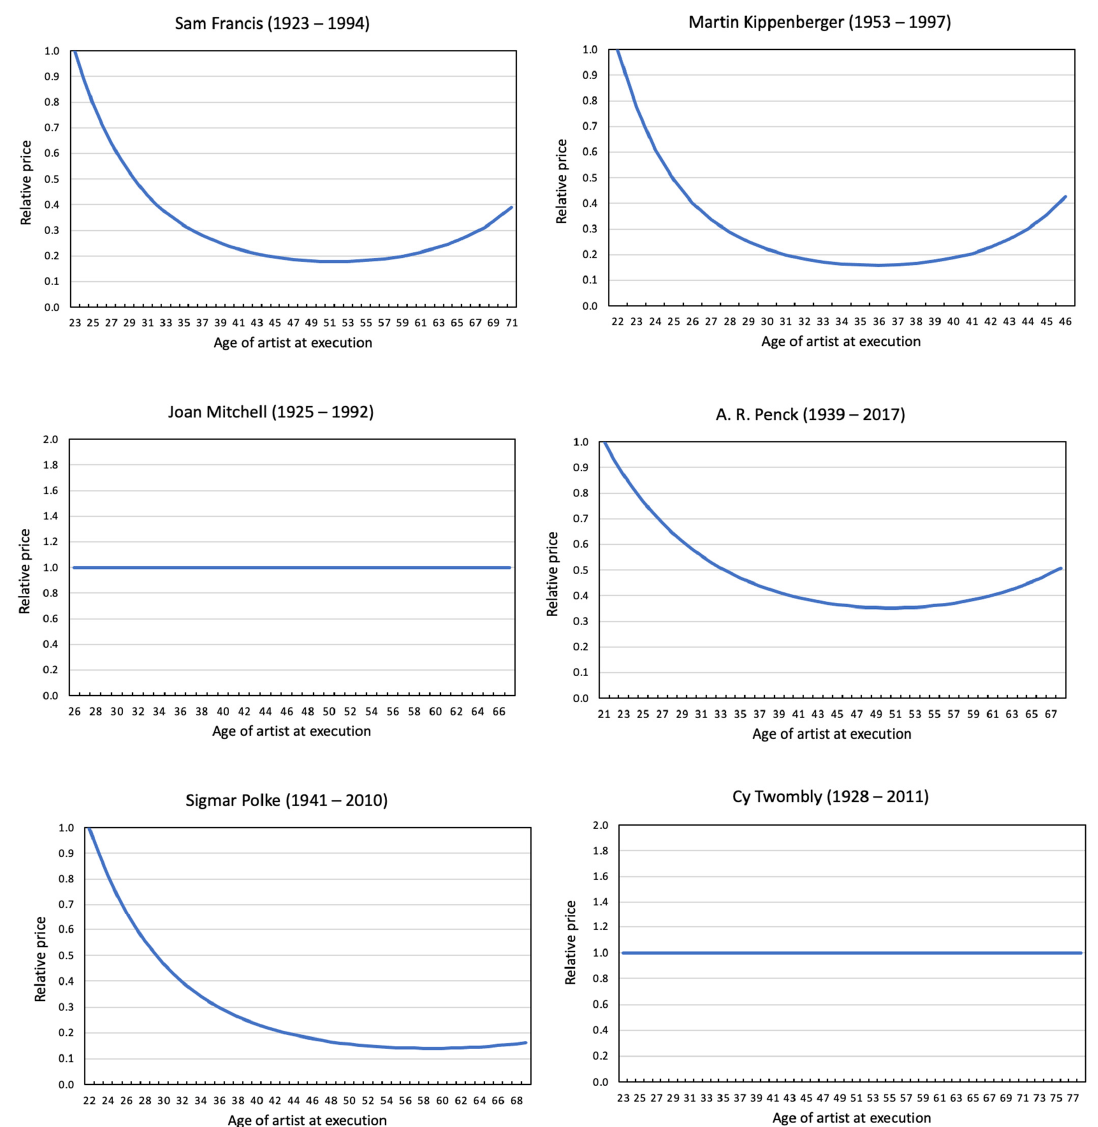
Figure 3. Relative prices for paintings executed at different ages by Sam Francis, Martin Kippenberger, Joan Mitchell, A.R. Penck, Sigmar Polke, and Cy Twombly. In David Galenson’s study of the age profiles for auction sales with 42 American or American-based contemporary artists, the ages at which prices peaked were typically dur- ing the years from the late 1940s to the early 1970s, a period when American art has been widely seen as innovative and world-leading (Galenson 1997). The highest prices paid for paintings by Sam Francis and Sigmar Polke were for paintings executed in the 1950s or 1960s, and suggest that some of the more recent cohort of collectors I have modelled may have continued to value art from the main movements of that time. Sam Francis is often